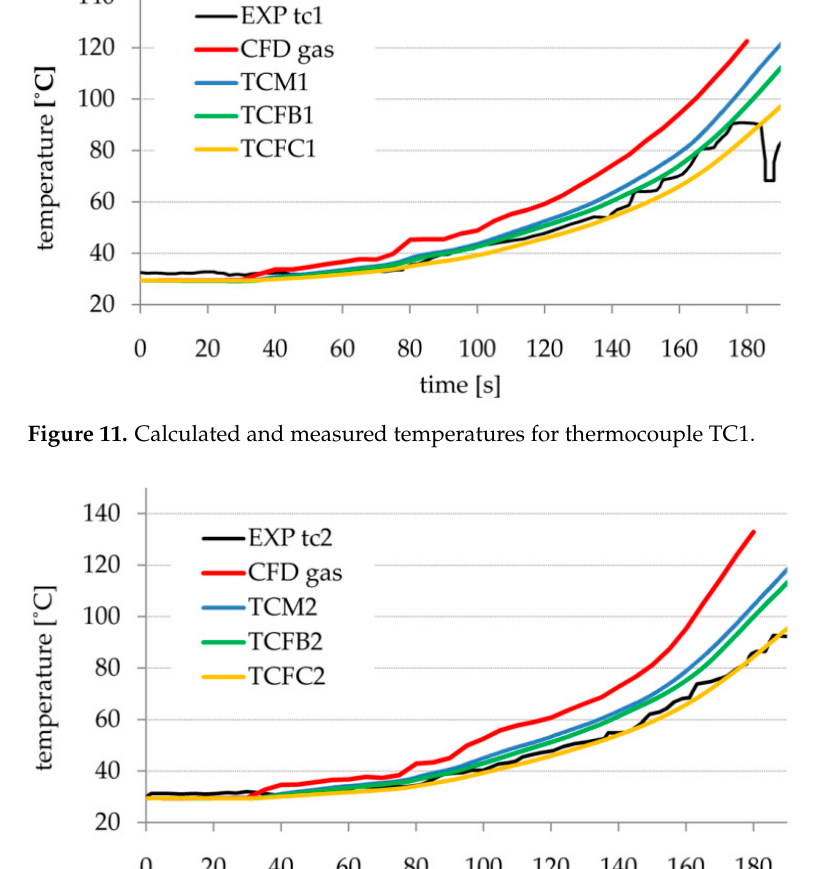
Figure 13. Calculated for different head diameters and measured temperatures for thermocouple TC1.